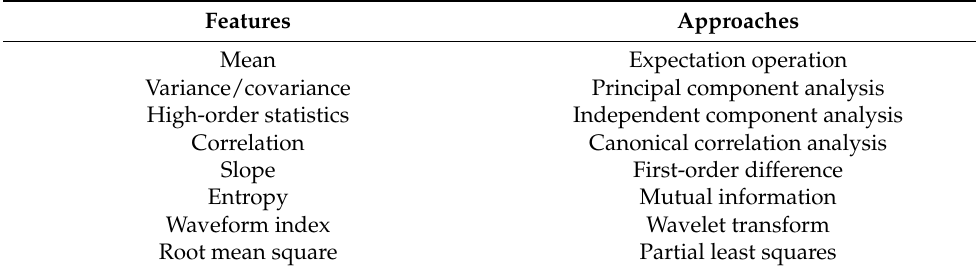
Table 1. Key signal features and data processing